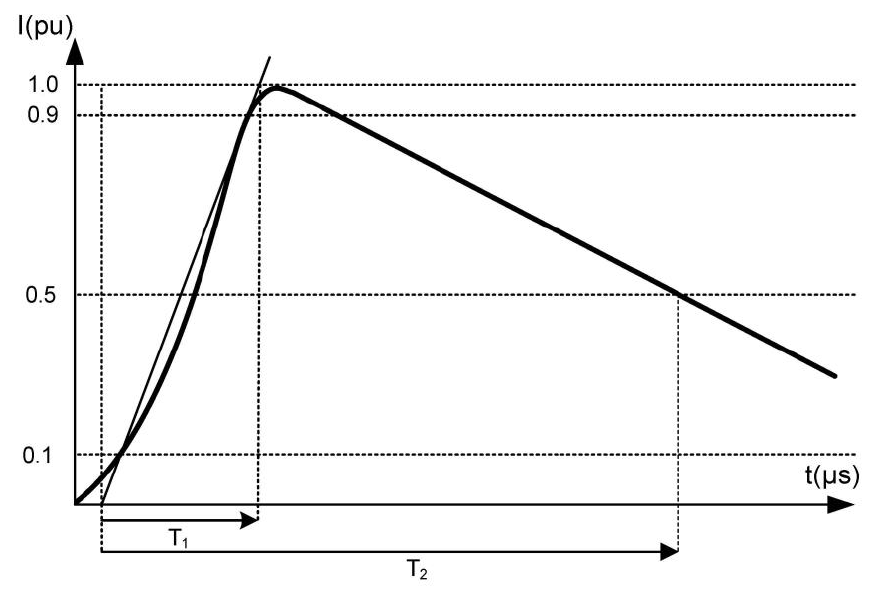
Figure 1. Rise time and time to half value schematic definitions [1].